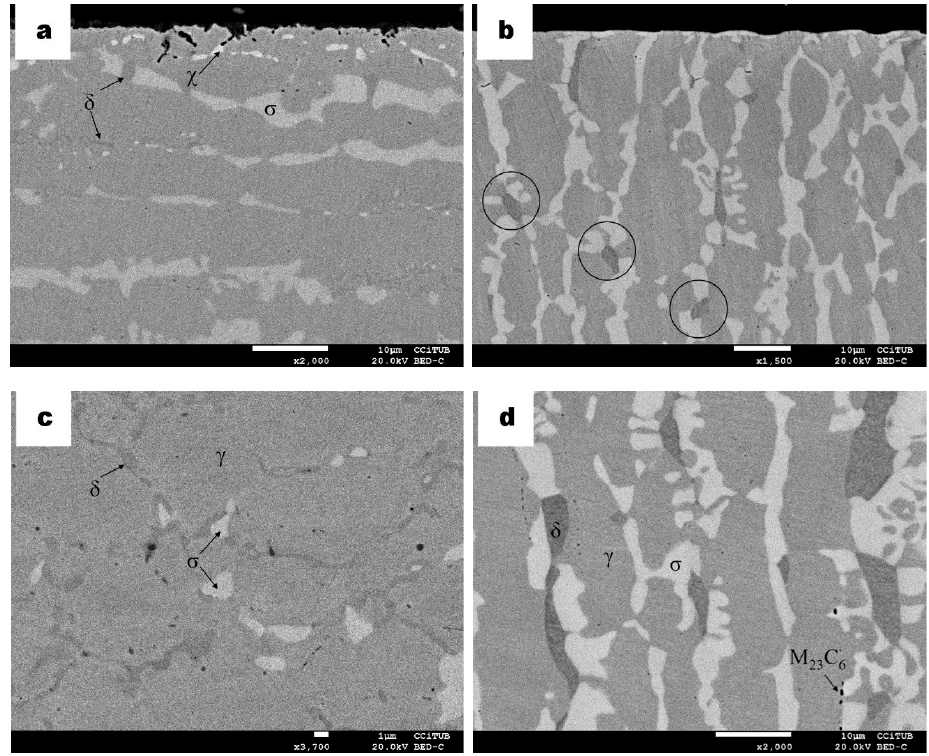
Figure 5. BSE micrographs of cross-section DSS specimens after 10 h plasma carburizing at 925 °C and thermal treatment at 830 °C for a short time. ( a ) Microstructure of the surface indicating ferrite δ (greyer phase) as well as sigma σ (bright phase) and chi χ (brightest phase). ( b ) Longitudinal cross section of the microstructure indication butterfly-like precipitation with black circles. ( c ) Higher magnification of central zone indicating austenite γ (grey phase), δ and σ . ( d ) Higher magnification of (b) indicating chromium carbides (black phase).